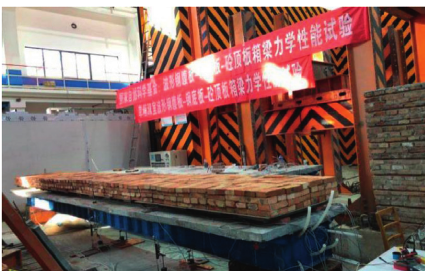
Figure 10: Uniform loading diagram of the single box and single cell continuous composite box girder with CSWSB.